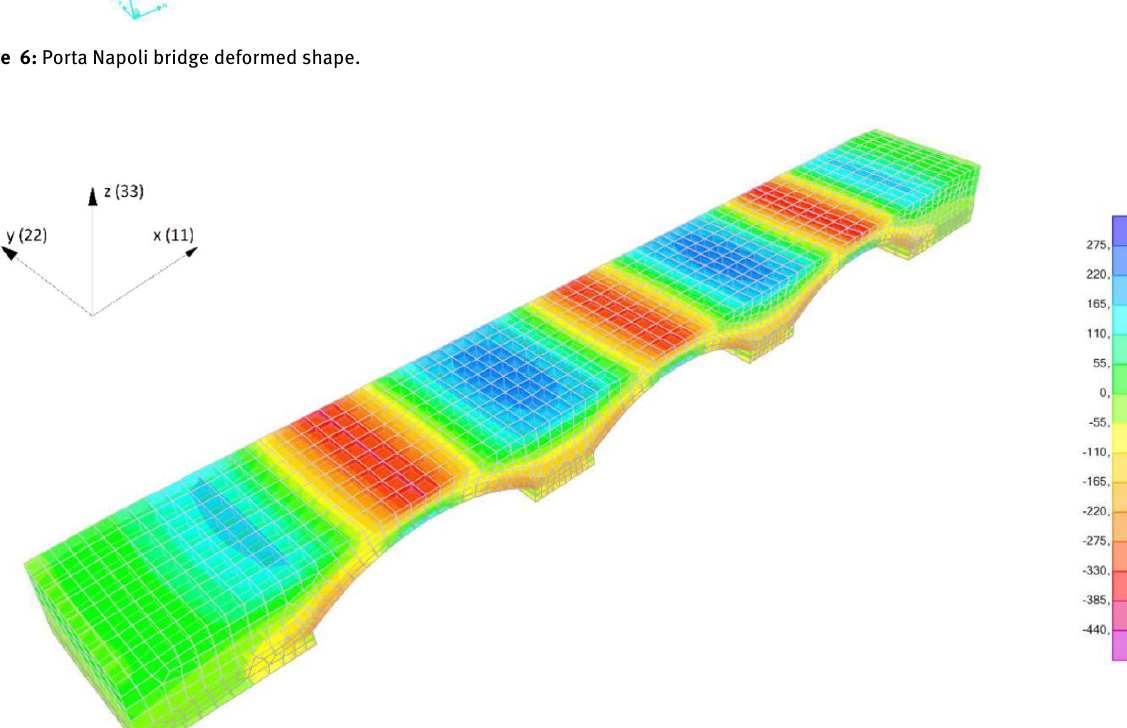
duces a state of equilibrium completely different from the original one. If the supports of an arch move, the arch it- self will fit into a new state of equilibrium, almost form- ing three hinges. If the thrust line is contained within the arch thickness, the arch is then stable. This limit, follow- ing Heyman [8, 9], is represented by the collapse condi-